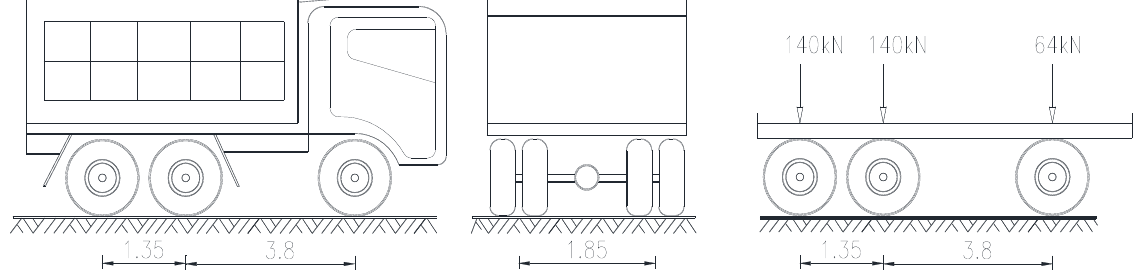
Figure 5. Commonly used truck wheelbase (unit: m).